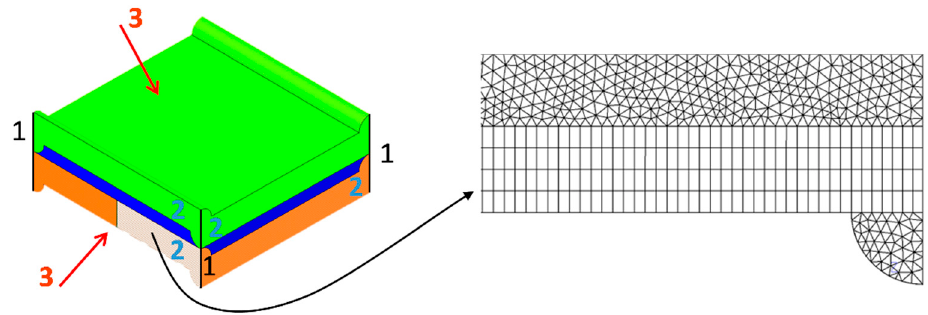
Figure 10. Computational domain. Numbers 1–3 indicate the mechanical boundary conditions (see text). A detail of the finite element mesh is shown on the right.